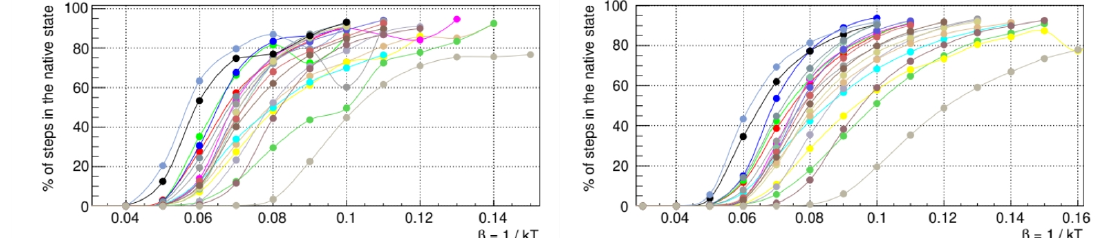
Figure 4. Fraction of configurations in the native states as a function of the inverse temperature β = 1/ k B T , for proteins with entanglement (left) and without entanglement (right). Each curve is for a given random sequence. The mean folding inverse temperature is found by averaging the points where the curves cross the 50%. The inverse temperature used in the folding simulations within the evolutionary process is fixed to this